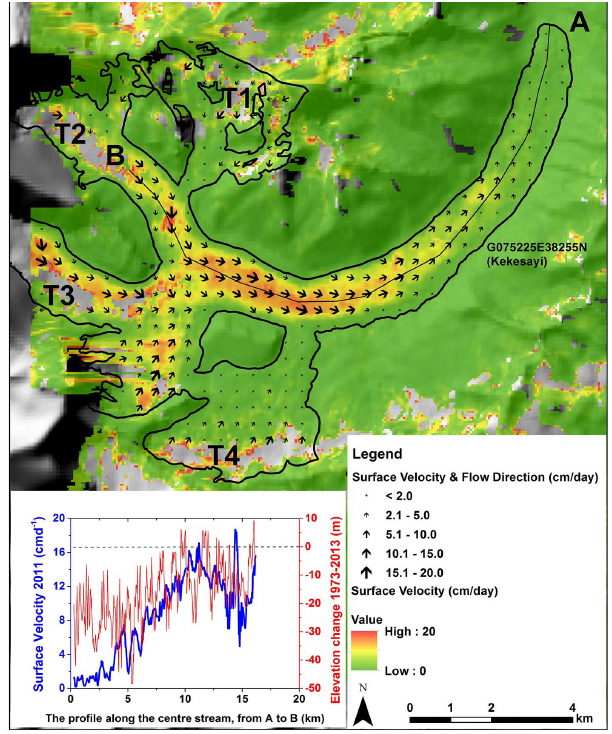
Figure 5. Surface velocities and flow directions of Kekesayi (G075225E38255N) Glacier in August 2011. The profile shows the surface velocities and the corresponding down-wasting (1973– 2013) along the central glacier flow line, upstream from A to